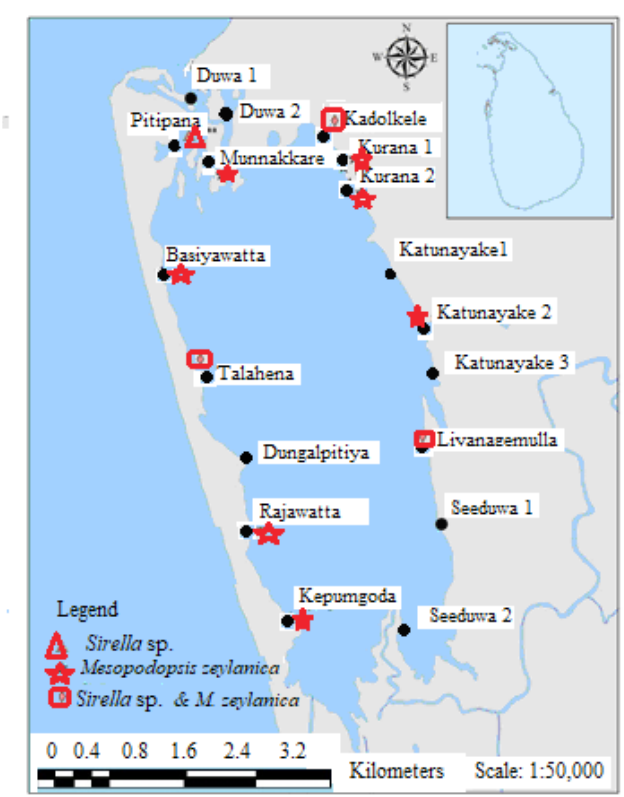
Figure 1: Distribution of mysid habitats, Negombo